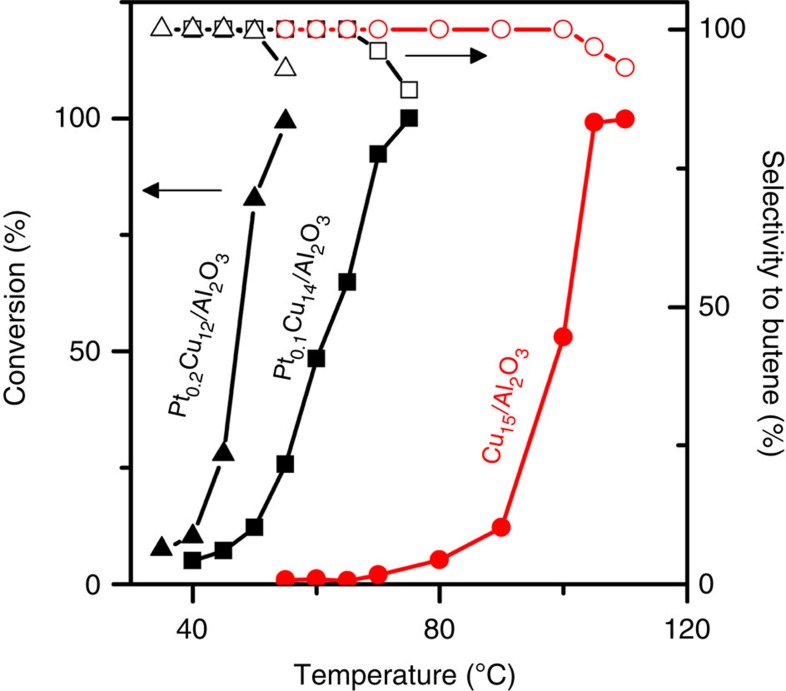
Selective hydrogenation of butadiene.Hydrogenation shown as a function of temperature over Cu15/Al2O3, Pt0.1Cu14/Al2O3 and Pt0.2Cu12/Al2O3 NPs (1,3-butadiene (1.25%), H2 (20%) and He (balance), GHSV=1,200 h−1).